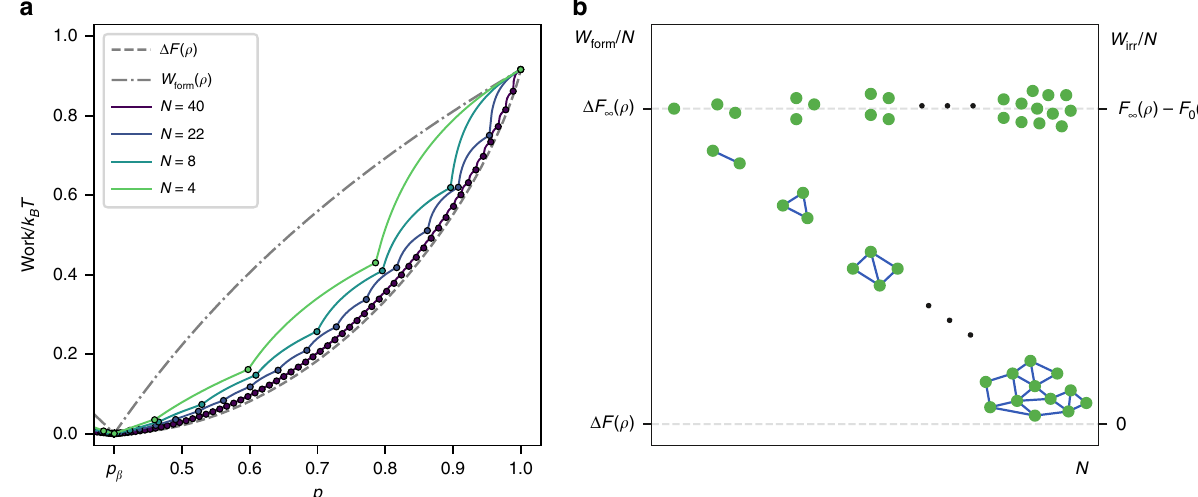
Fig. 3 Asymptotic behavior of the minimum work of formation of correlated copies as the number of copies increases. a The minimum work of formation of = N is plotted in color for different values of N (solid lines) as a function of the local reduced state, correlated copies ( c -work of formation) per copy W form ρ = (1 − p )|0 〉〈 0| + p |1 〉〈 1|, parametrized by the excited state probability p . As N increases W = N approaches the standard free energy difference Δ F form (dashed gray line) for every state and the number of reversible states ( R (cid:9) -states) (represented by dots) increases linearly with N . In addition, for irreversible states the degree of irreversibility per copy, measured by the difference between the work of formation (solid colored line) and the extractable work (nearest point to the left), decreases with N . b Illustration of the results obtained for correlated copies. As N increases the work of formation per copy approaches the free energy difference and furthermore the irreversible work per copy goes to zero; thus recovering